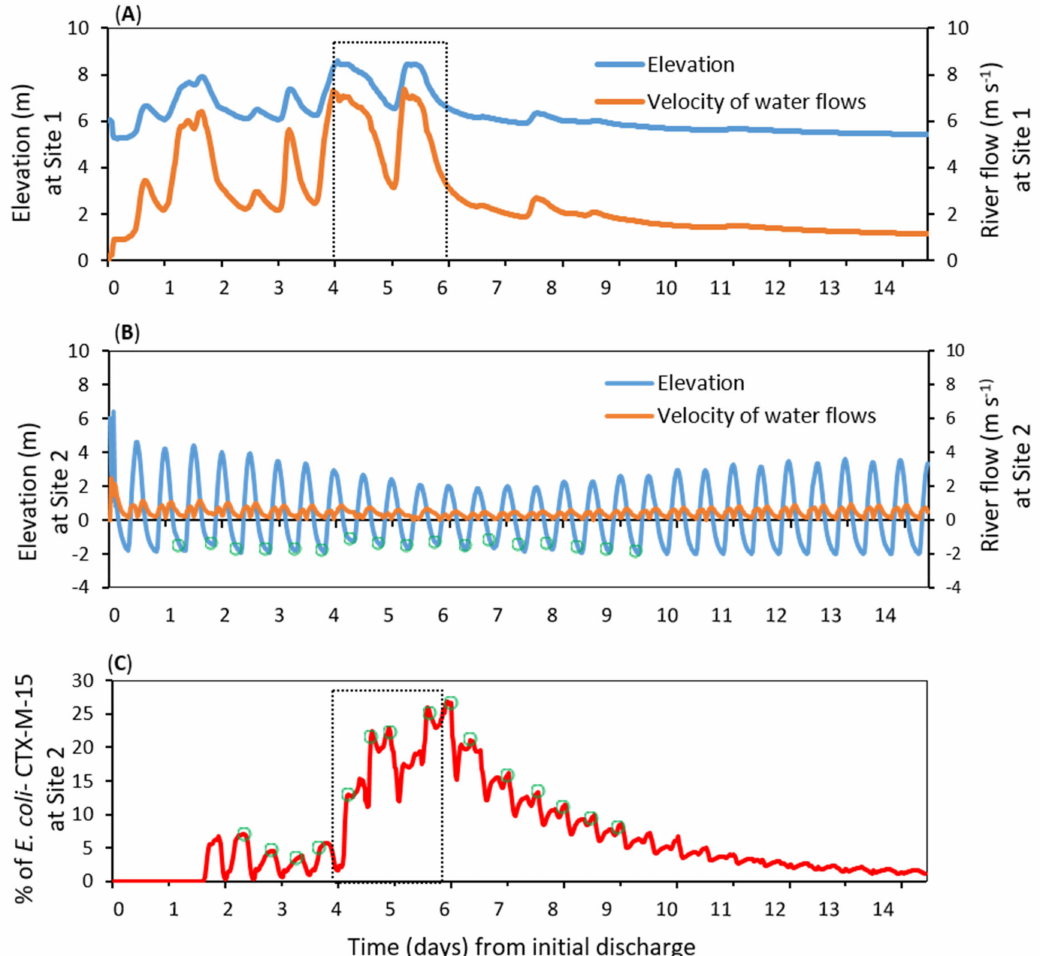
Figure 3. Simulation of water level (m) and river flow (m / s) at ( A ) the wastewater discharge point (Site 1) and ( B ) the estuary mouth (Site 2); ( C ) bla CTX-M-15 -producing E. coli concentration at the estuary mouth. Dashed squares denote the storm period, with the highest flows and E. coli loadings. Green cycles show peaks in concentration during ebb